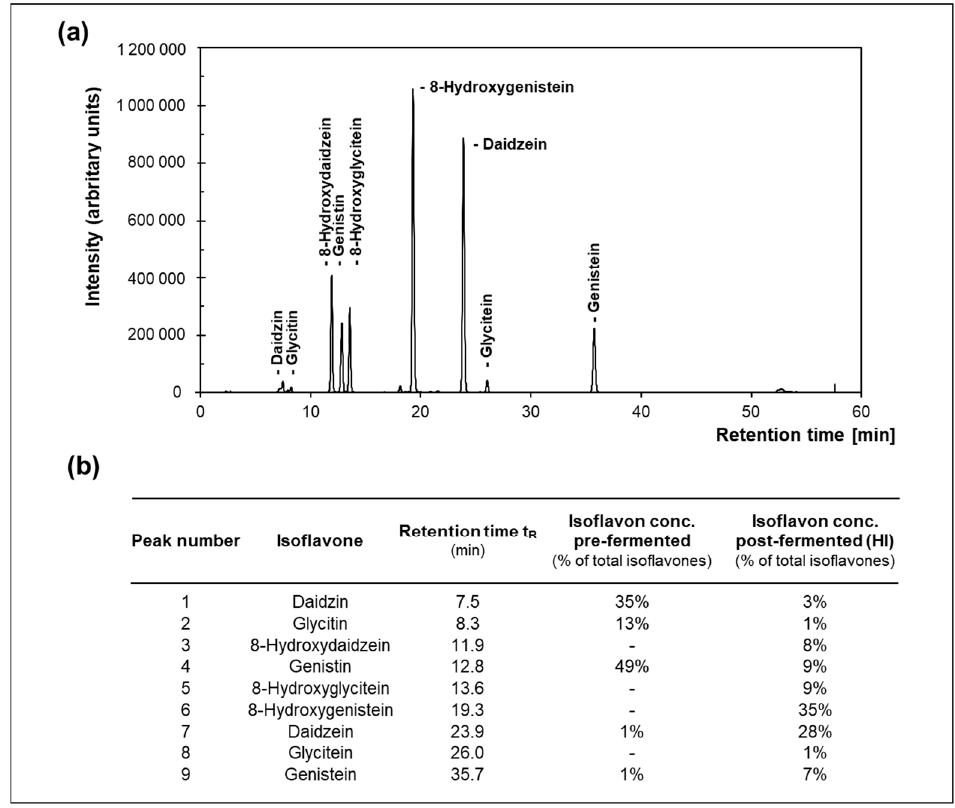
Figure 2. ( a ) Representative HPLC chromatogram of hydroxy-isoflavones (HI)-enriched post-fermented soybean extract at 254 nm and ( b ) the corresponding relative concentrations of identified isoflavones in pre- and post-fermented soybean extract.